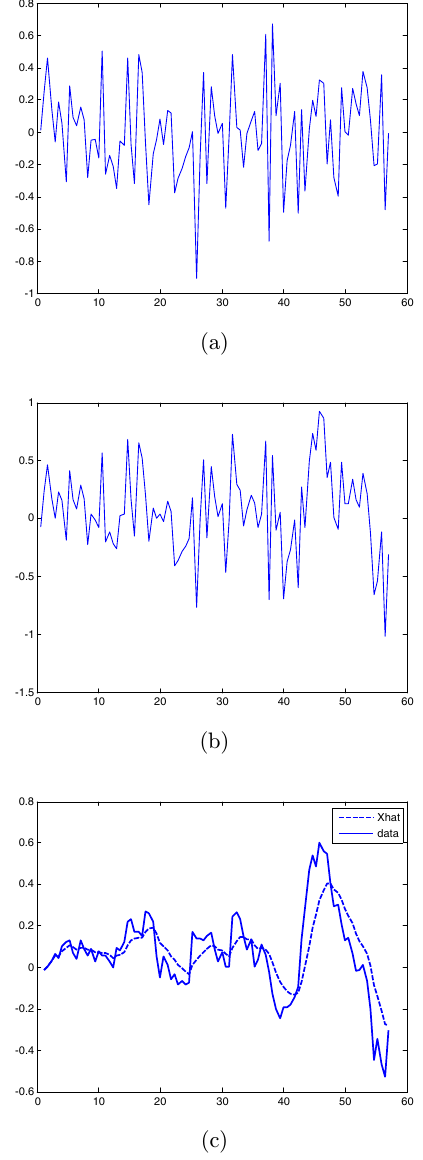
Fig. 3. (a) A typical pattern of an arti¯cial noise (we assume as white and Gaussian), (b) The noise in (a) added to an fNIRS signal, (c) The contaminated signal in (b) is cleaned by AR based method (dashed line) and the original motionless signal (solid